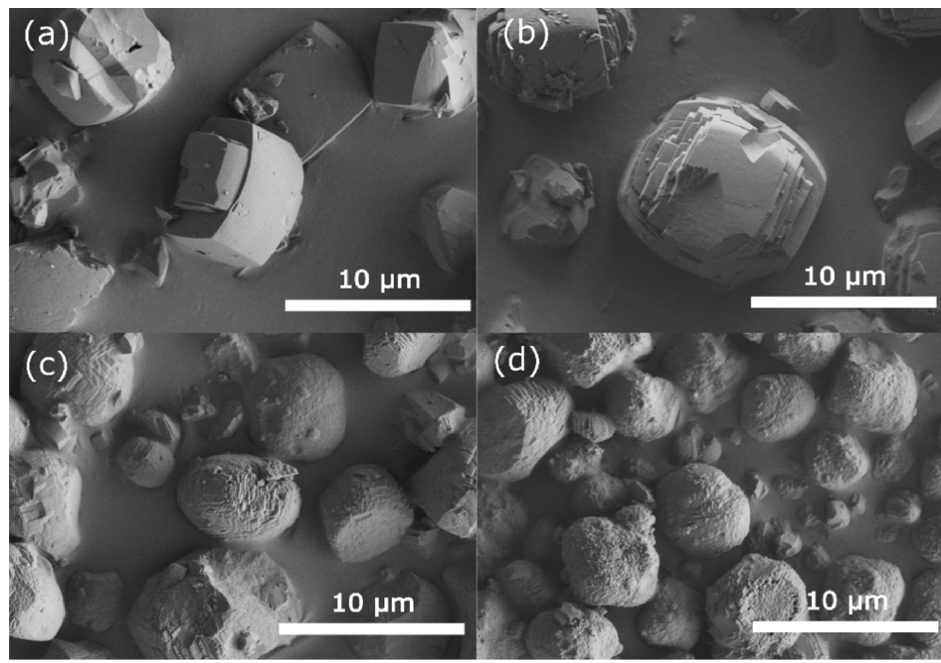
Figure 3. Comparison of morphologies of prepared H-ZSM-5 zeolite samples by SEM imaging at magnification x 5000: ( a – d ) samples Z-inf, Z-250, Z-80, Z-35; from Si-rich (Z-inf) to Al-rich samples (Z-35) typical coffin-shaped zeolites of approx. 10 µ m switch to smaller spheres of approx. 4 µ